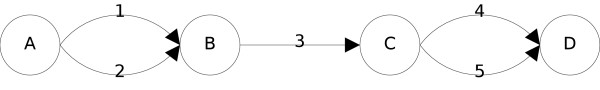
Example network.